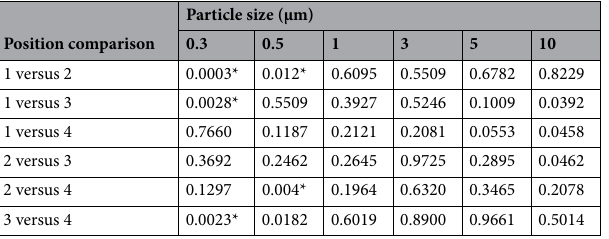
Table 3. P values for comparisons between Position across all Heights. * = statistical significance with a 0.05 threshold.